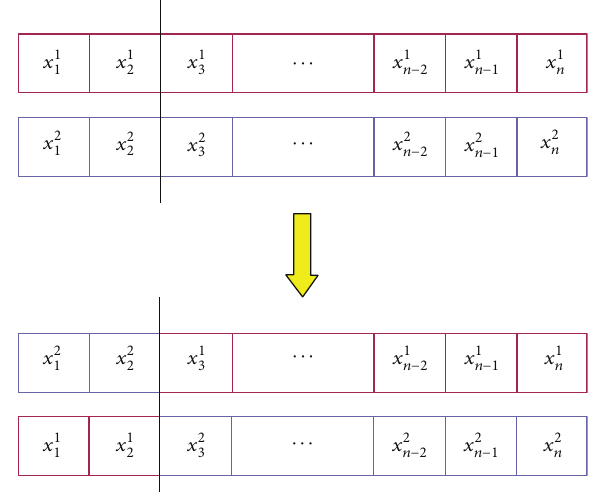
Figure 1: Illustration of the general crossover function in